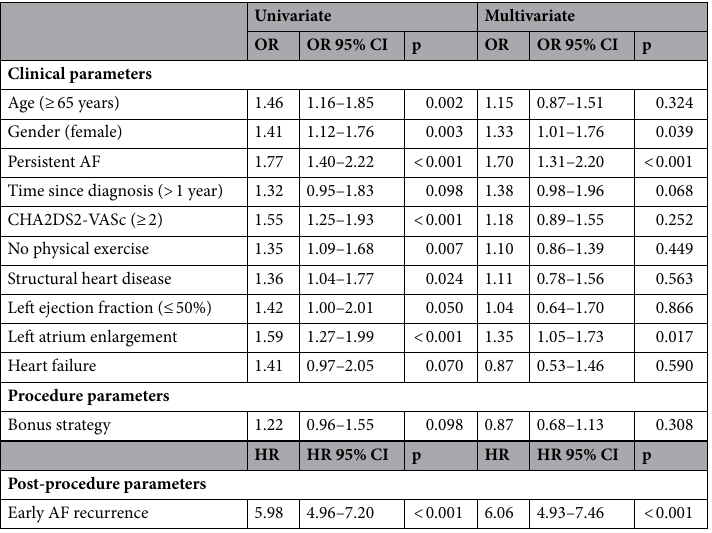
Table 6. Predictors of AF